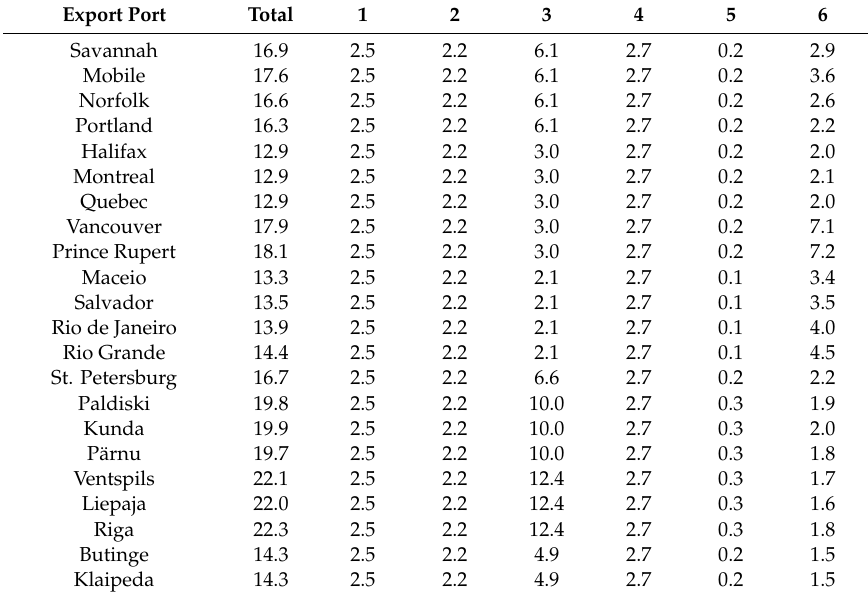
Table A13. Overview of supply chain GHG emissions of pellets produced from roundwood, transported over500kmtoexportportsandincluding50kmfeedstocktransport, inkgCO 2 -eq / tpellets. Components included in the table: 1. Silviculture and harvest; 2. Feedstock transport; 3. Pelletizing; 4. Pellet transport; 5. Shipping; 6. Port